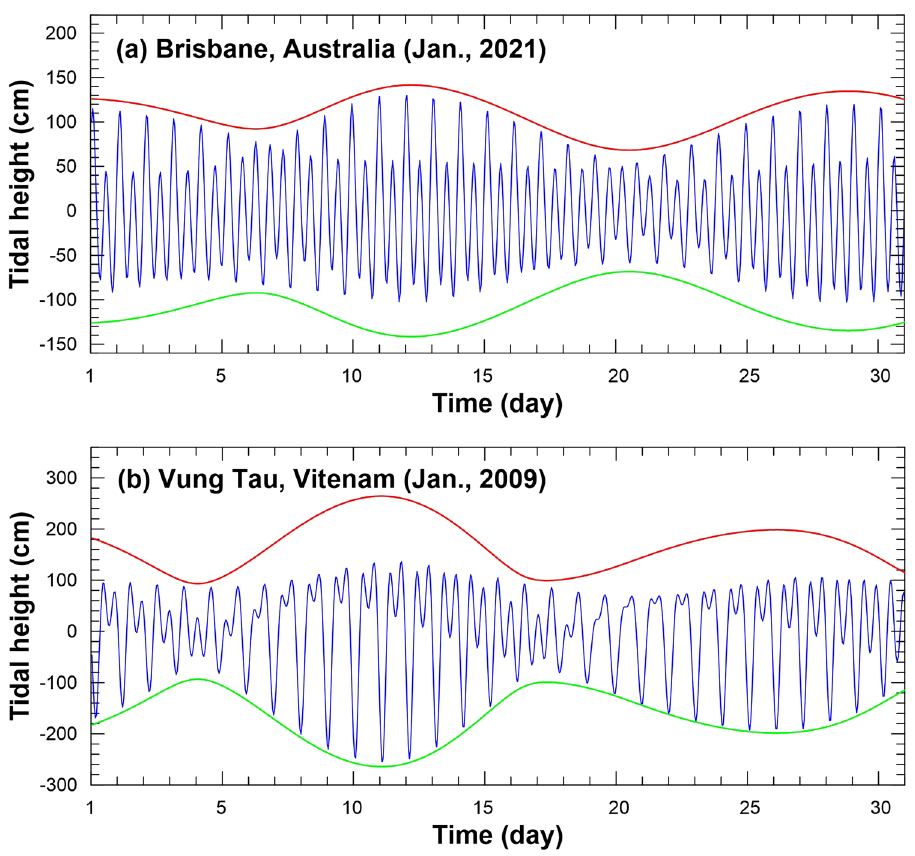
Figure 2. Comparison of different types of tidal pattern asymmetry using observed tidal height time series versus the maximum and minimum tidal envelope curves (green lines) for: ( a ) Brisbane, Australia (January 2021), with its upper tidal envelope dominant regime, and ( b ) Vung Tau, Vietnam (January 2009), with its lower tidal envelope dominant tidal regime, with both sites featuring mixed, mainly semidiurnal